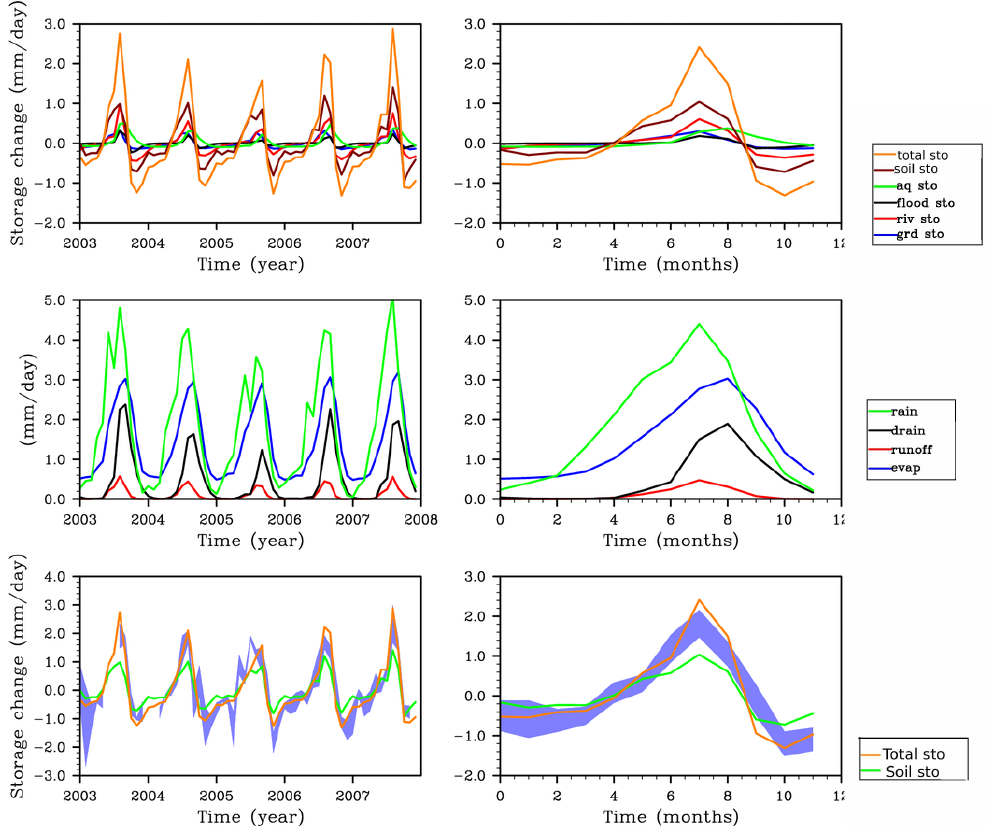
Fig. 12. Basin water storage change (mmday − 1 ) of each reservoir (top). Time evolution of rain, runoff, drainage and evaporation over the basin (middle). Basin water storage change (mmday − 1 ) in all reservoirs compared to GRACE datasets (down). The blue range is the difference between the maximum and the minimum GRACE products values. Left panels represent interannual variations (monthly averages) and right panels are the annual variations (each month is averaged over the whole 5yr